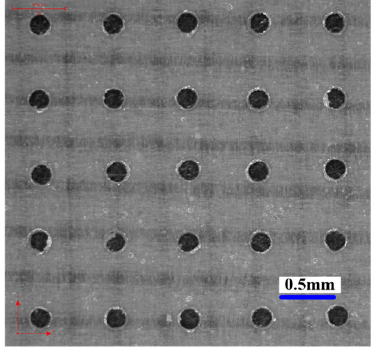
Figure 7. The mask used in the experiment.